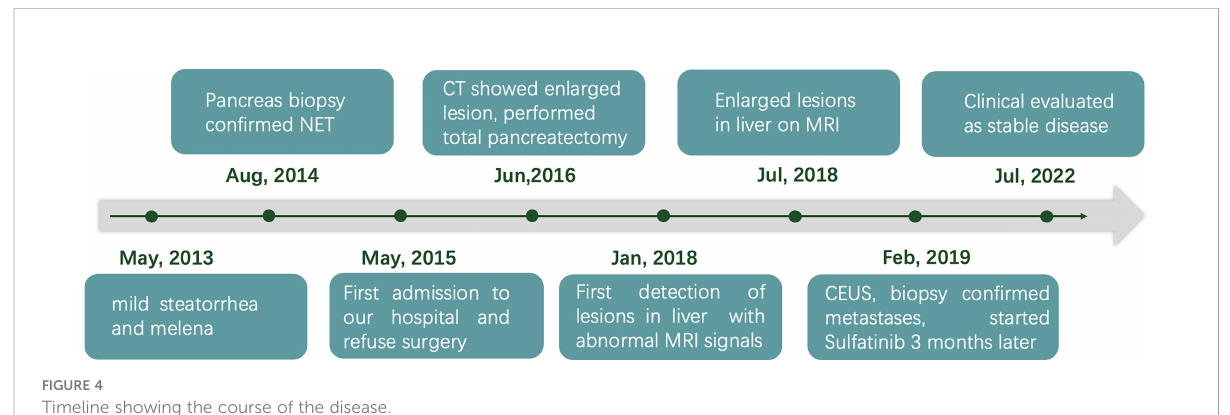
FIGURE 4 Timeline showing the course of the